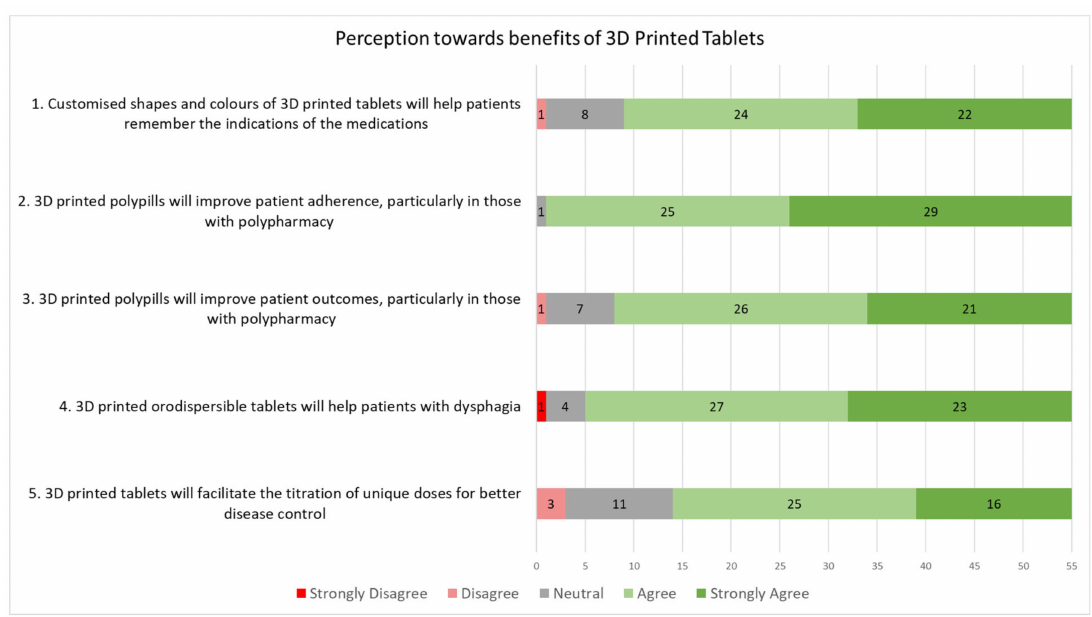
Figure 2. Responses to statements on the benefits of 3D printed tablets.